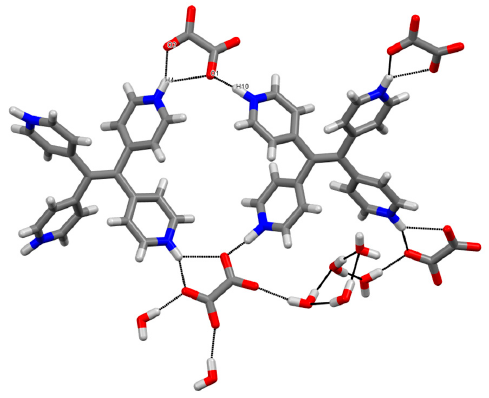
Figure 2. Charge-assisted H-bonding interactions in oxalate-bridged tetra(pyridinium)ethylene co-crystals.